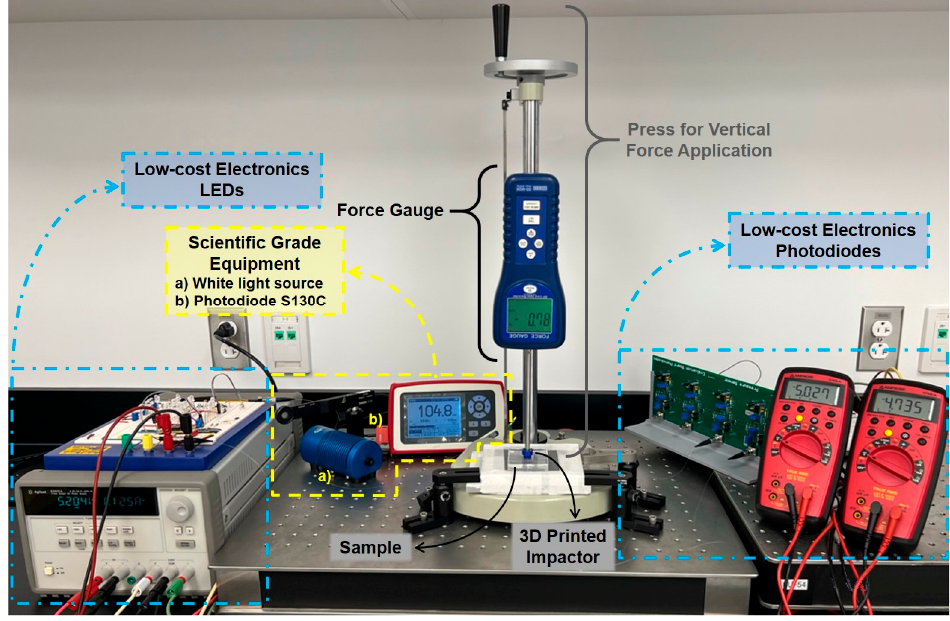
Figure 4. Tools and equipment used in experimental setups.